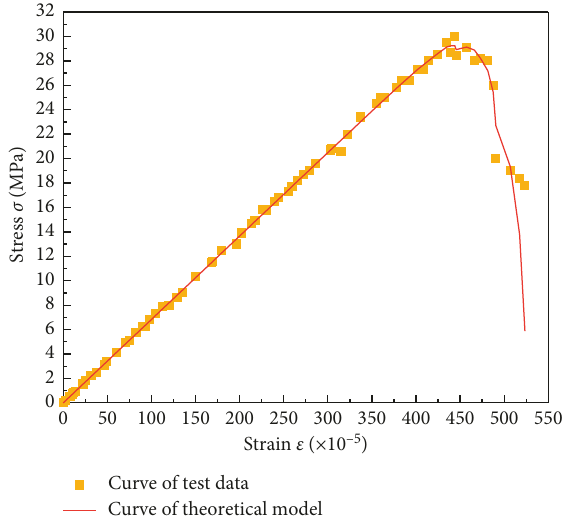
Figure 13: Comparison between test and model about relationship of σ , ε at strain gauge